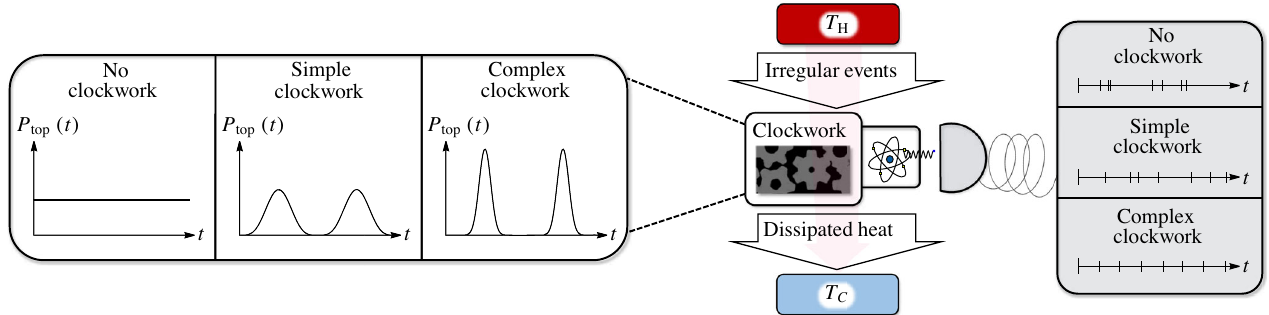
FIG. 1. Illustration of timekeeping at the level of individual irreversible events. The equilibration events that follow the second law of thermodynamics are inherently stochastic and irregular; in our example, we use radiative decays from an excited energy level of a quantum system (which we label “ top ” ). By inserting an autonomously operating clockwork between the two out-of-equilibrium systems ( “ hot ” decaying quantum systems and a “ cold ” environment), these decays are temporally structured by temporal variation of the population of the top level, a task that we refer to as autonomous temporal probability concentration. This task concentrates the probability of such a decay around the oscillatory peaks of excited population. The panel on the right showcases how greater clockwork complexity leads to a regularization of individual thermalization events, i.e., clock ticks, starting from a thermal population with randomly distributed ticks depicted above, continuing to a simple clockwork with limited population and still significant variance, resulting in ticks being more likely during peak populations and, thus, less frequent and more regular, and then finally a complex clockwork, increasing population while decreasing temporal variance, giving yet more regular ticks. The tick distribution on the right is exemplary and depicts random ticks, whose spacing approximates the cycle time of the clockwork as the temporal probability becomes more concentrated around sharp